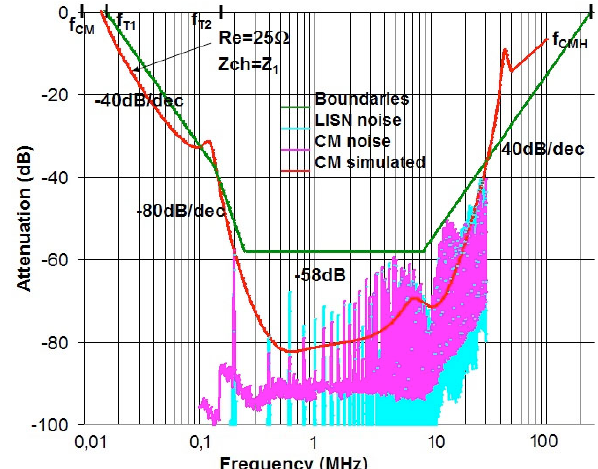
Figure 16: Comparison of the CM filter attenuation measured and simulate when the NiZn core around the three power wires.